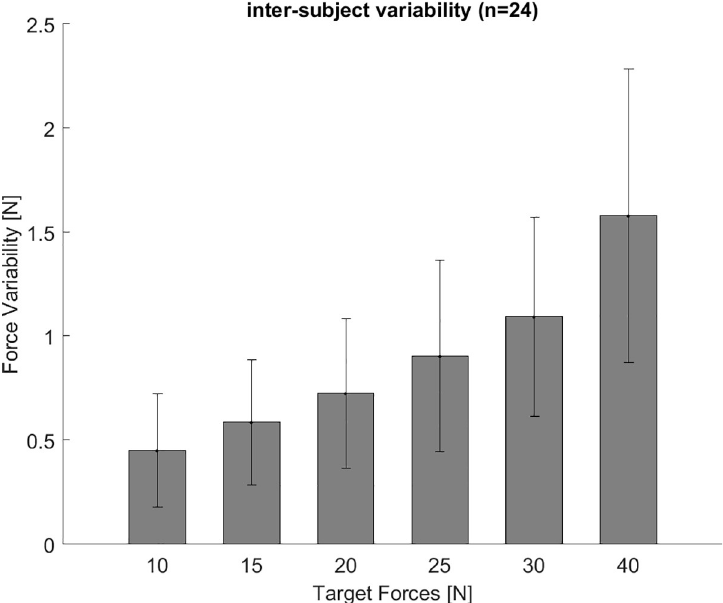
Fig 7. Force variability ‘no cable excursion’ trials. The force variability increases with increasing target force for the ‘no cable excursion’ trials. The bars indicate the group’s average and the whiskers the standard deviation.